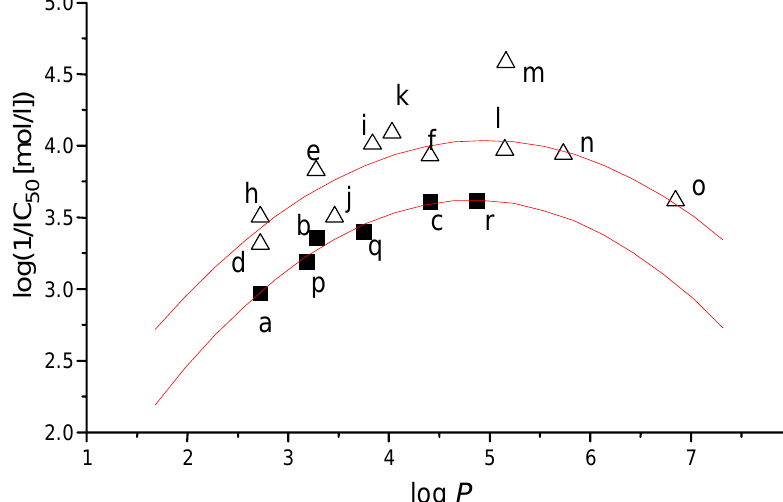
Figure 1. Quasi-parabolic dependence between photosynthesis inhibitory activity and log P of studied amides 2a-r